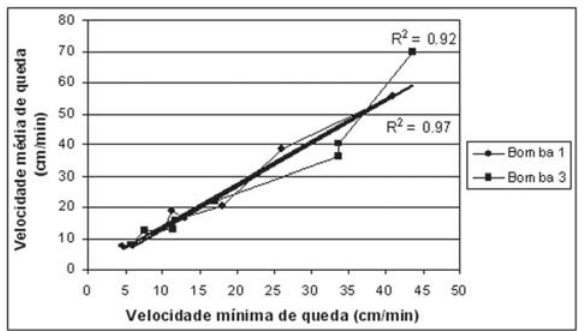
Fig. 5 – Comparação entre a velocidade de queda no ponto 0 e a velocidade média em três pontos para várias